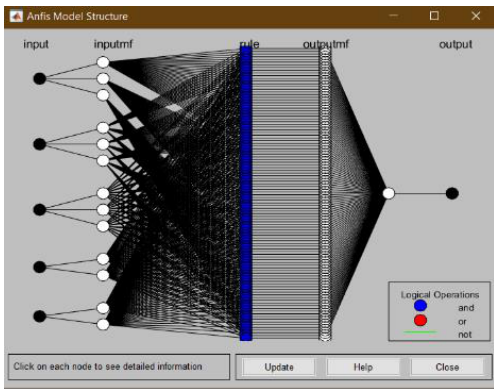
Figure 4. Screenshot of the constructed ANFIS model.